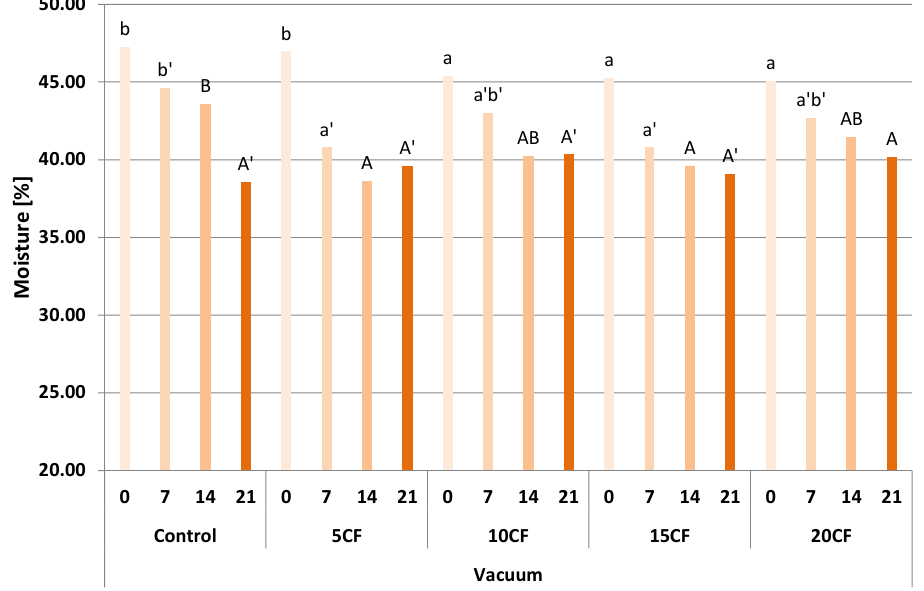
Figure 2. Moisture of the crumb of gluten-free breads with the addition of chestnut flour in the amount of 5% (5CF), 10% (10CF), 15% (15CF) and 20% (20CF) after 7, 14 and 21 days of storage, packed in a barrier film with a vacuum. Values marked with the same symbols mean no statistically significant differences (α = 0.05).